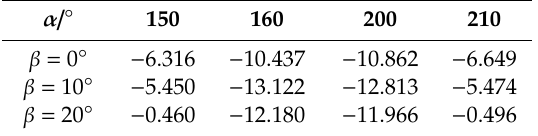
Table 5. Influence of elevation angle on RCS mean of m low , N obs,low = 1, RCS unit: dBm 2